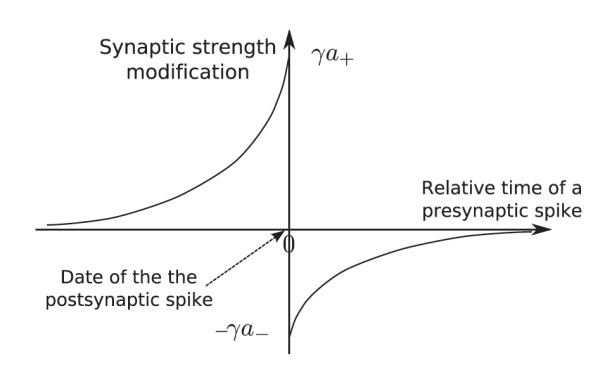
This figure represents the synapse strength modification when the post-synaptic neuron emits a spike. The y-axis corresponds to an additive or multiplicative update of the connectivity. For instance, in [28], this is ΔWijWij for the negative part of the curve. However, we assume an additive update in this paper. The x-axis is the time at which a pre-synaptic spike reaches the synapse, relatively to the time of post-synaptic time chosen to be 0.